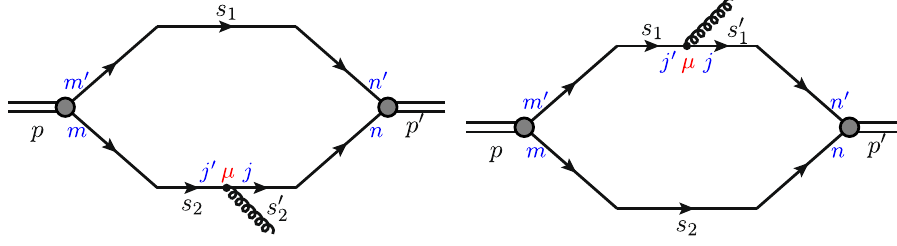
Fig. 1 Radial wave functions for the 0 + ( bc ) -diquark in a the ground state and b the first radial excited state Fig. 2 Scattering